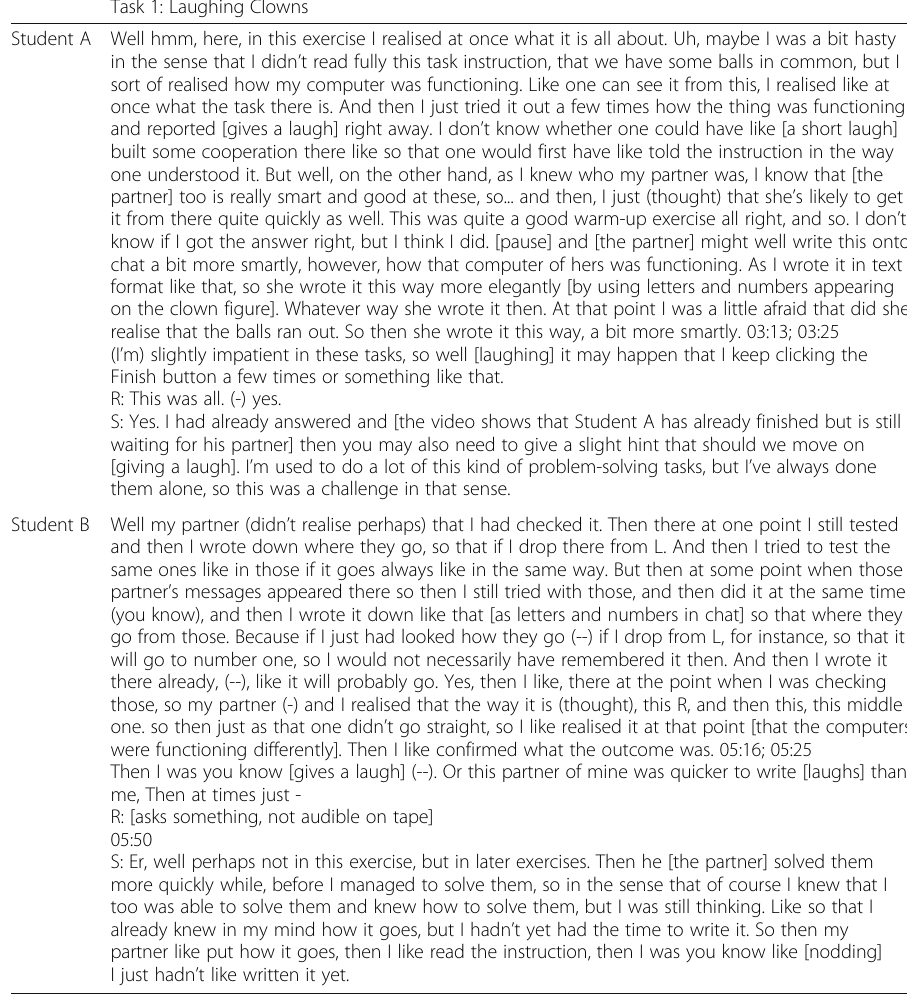
Table 4 Example of verbal reports (CRR data, Laughing Clowns) (translated from Finnish) Task 1: Laughing